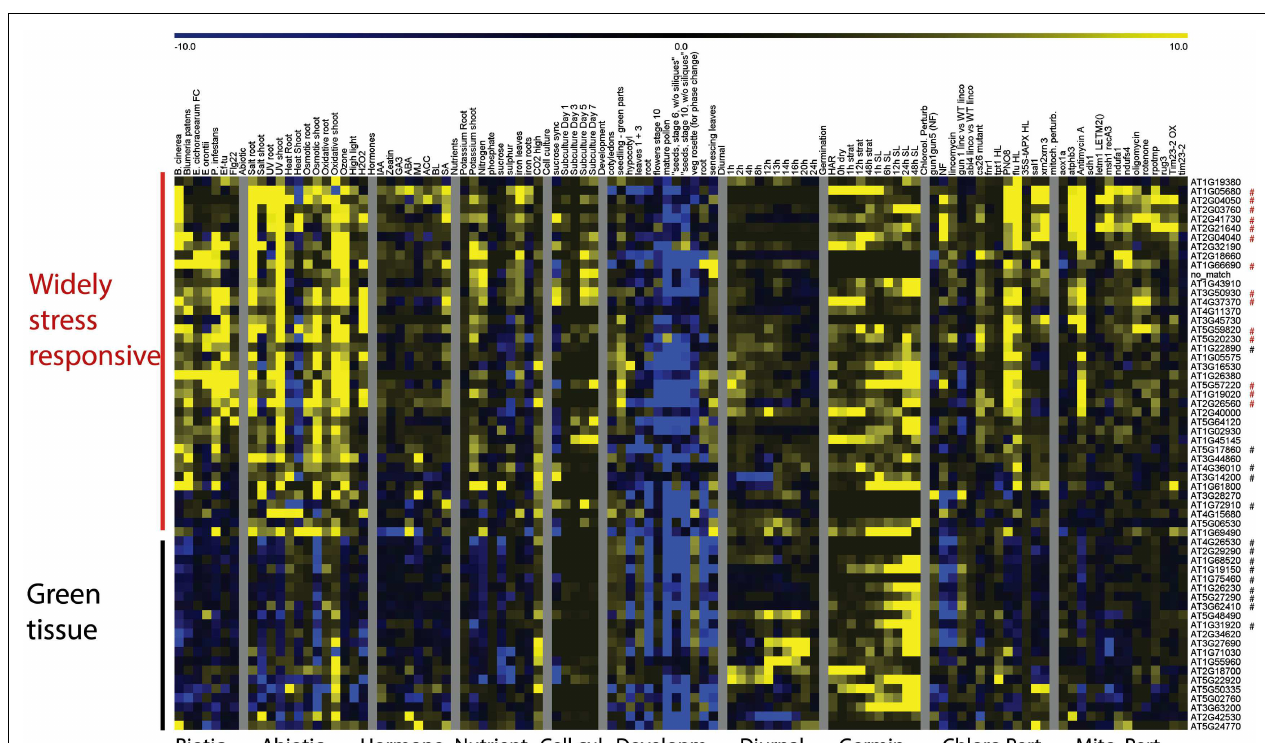
related microarray experiments. Red asterisks indicate probe sets that were also commonly altered by mitochondrial perturbations, black asterisks indicate probe sets that were specifically responding to chloroplast